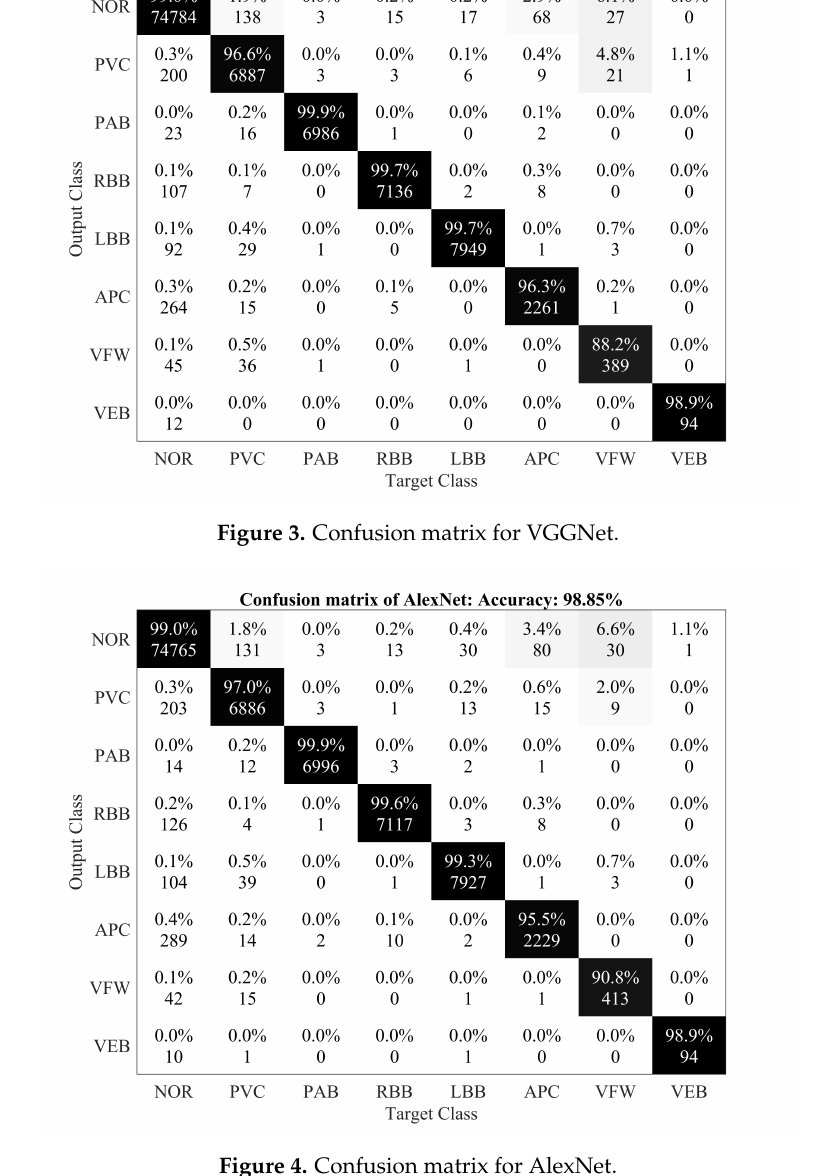
Figure 4. Confusion matrix for